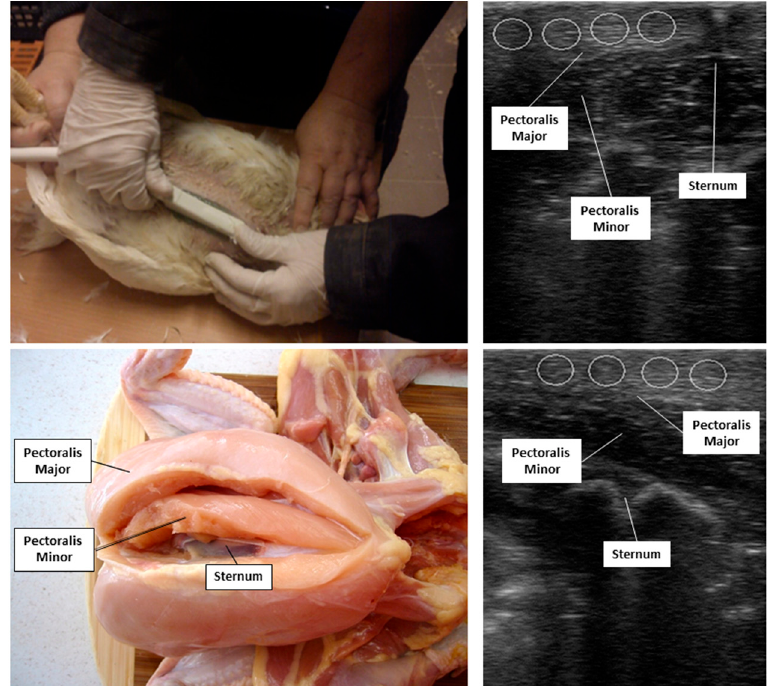
Figure 1. In situ ultrasonographic examinations (upper left) of pectoralis major muscles (bottom left—https://kriegerscience.wordpress.com/2010/11/09/dissecting-a-whole-chicken/) in broiler chickens (n = 40) scanned in a transverse (upper right) or longitudinal (bottom right) plane: The white circles in the panels depicting ultrasonograms indicate the potential placement of four computer-generated circular areas of interest (spot meters) used for echotextural analyses of the muscle tissue.